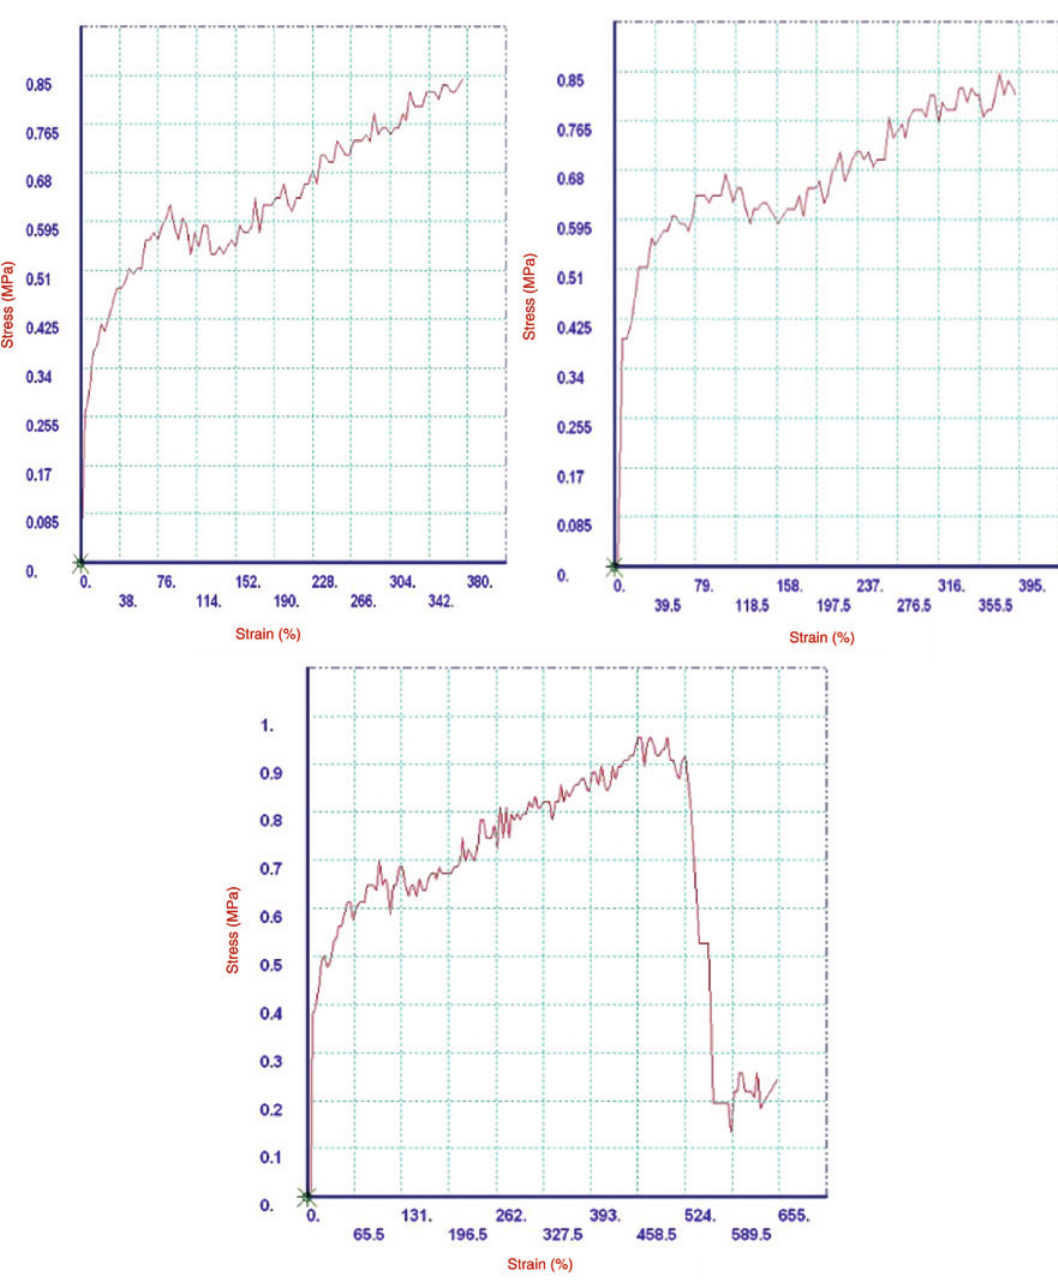
Figure 11: Stress-strain curve of coir fiber-reinforced vulcanized NR composite after heat resistance at 80 ° C for 4 h.